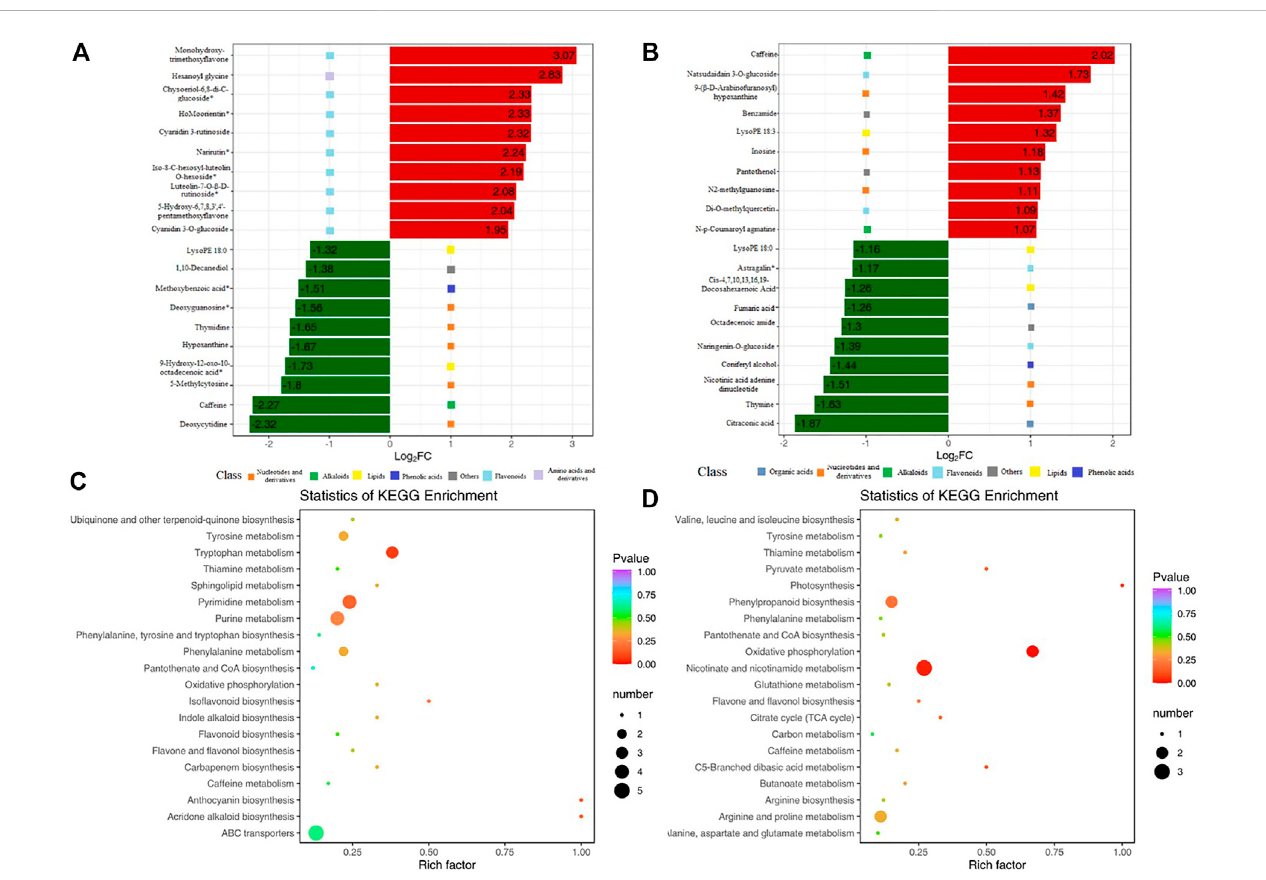
KEGG enrichment pathway of DMs and bar chart of top 10 DMs. (A) Top 10 upregulated and downregulated DMs for KR. Red bars means upregulated DMs.Green barsmeansdownregulated DMs. (B) Top10upregulatedand downregulated DMs for MR. (C) KEGGenrichmentpathwayofDMs forKR. (D) KEGG enrichment pathway of DMs for